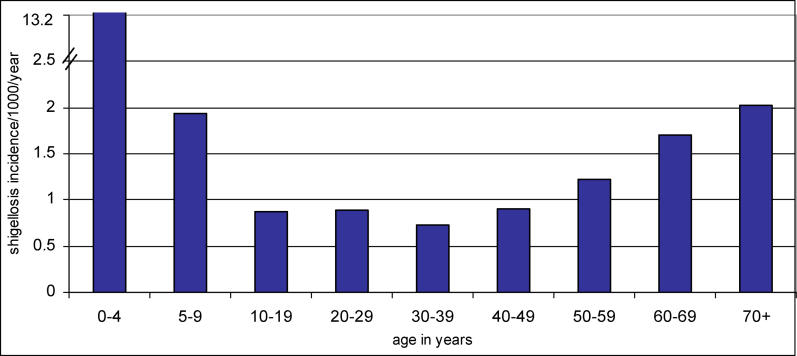
Overall Shigellosis Incidence by Age Group at Study Sites in Six Asian CountriesNote: Shigellosis incidence in the age group 0–4 y is 13.2/1,000/y.